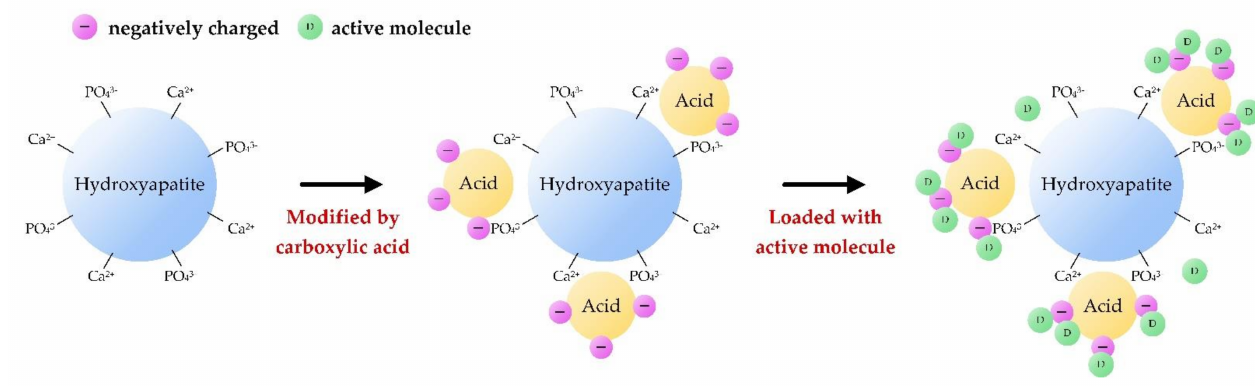
Figure 2. Schematic diagram of drug adsorption on the surface-modified HANPs. ( − : negatively charged biding sites on surfaces of modified HANPs; D: active molecule of